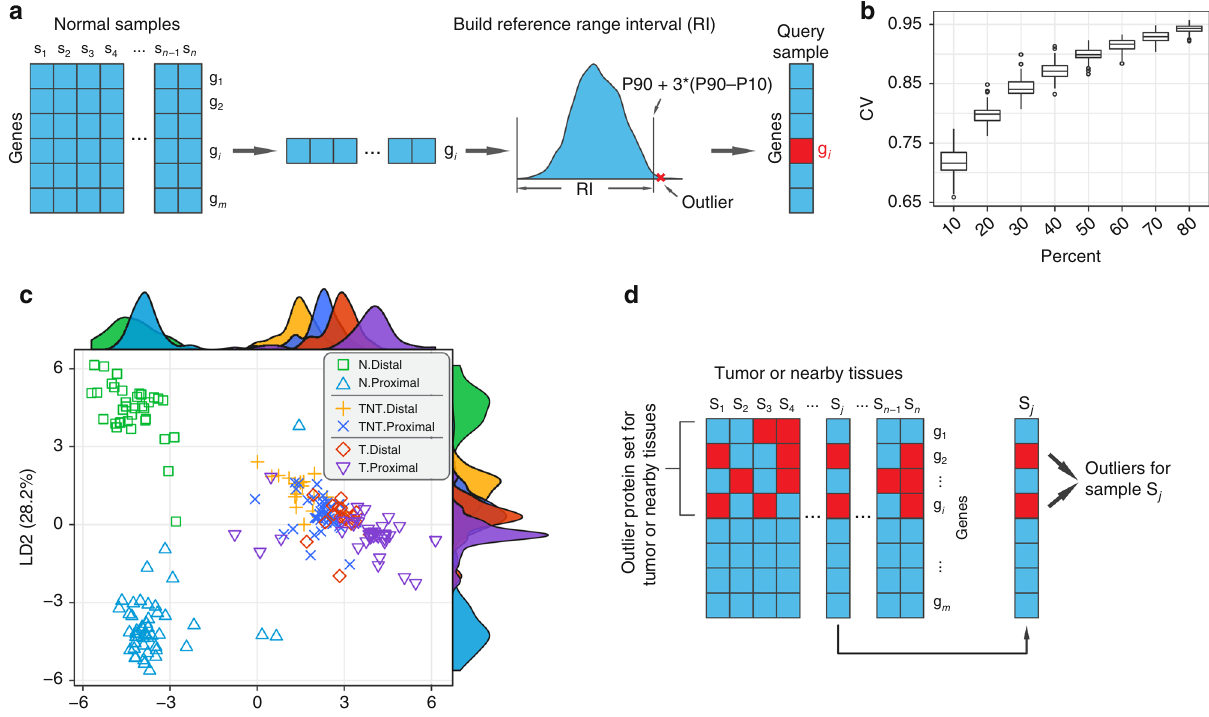
Fig. 4 The proteome reference range of mucosa. a A fl owchart to illustrate the construction of the proteome reference intervals (RI) based on 82 normal mucosa samples. Outlier proteins ( fi lled red square) are called if their abundances are out of the upper limit of RI. b Boxplot displaying the median abundance of proteins and their variations estimated by subsampling a certain fraction of all samples (10 – 80%) with replacement (center line: median, bounds of box: 25th and 75th percentiles, and whiskers: from Q1 − 1.5*IQR to Q3 + 1.5*IQR). c Linear discriminant analysis (LDA) of mucosa samples classi fi ed into six groups. Green squares: normal tissues from the distal section; sky blue triangles: normal tissues from the proximal section; range pluses: tumor nearby tissues from the distal section; blue crosses: tumor nearby tissues from the proximal section; red diamonds: tumor tissues from the distal section; and violet triangles point down: tumor tissues from the proximal section. d A fl owchart to illustrate the identi fi cations of anomaly gastric conditions based on the outlier protein